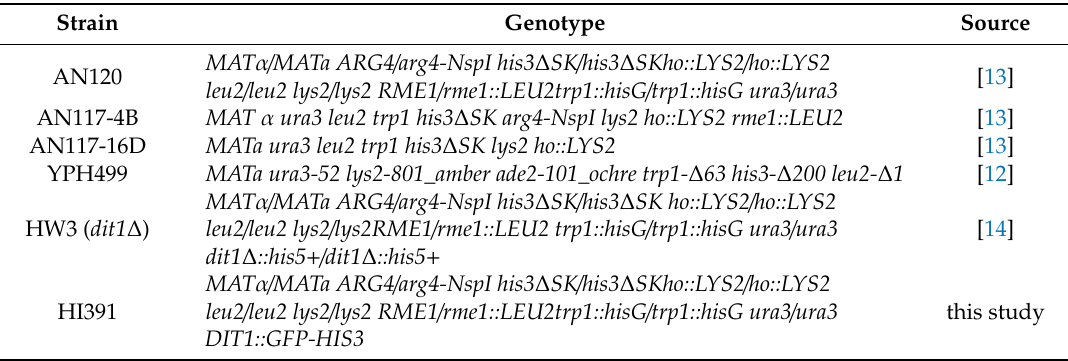
Table 1. Strains used in this